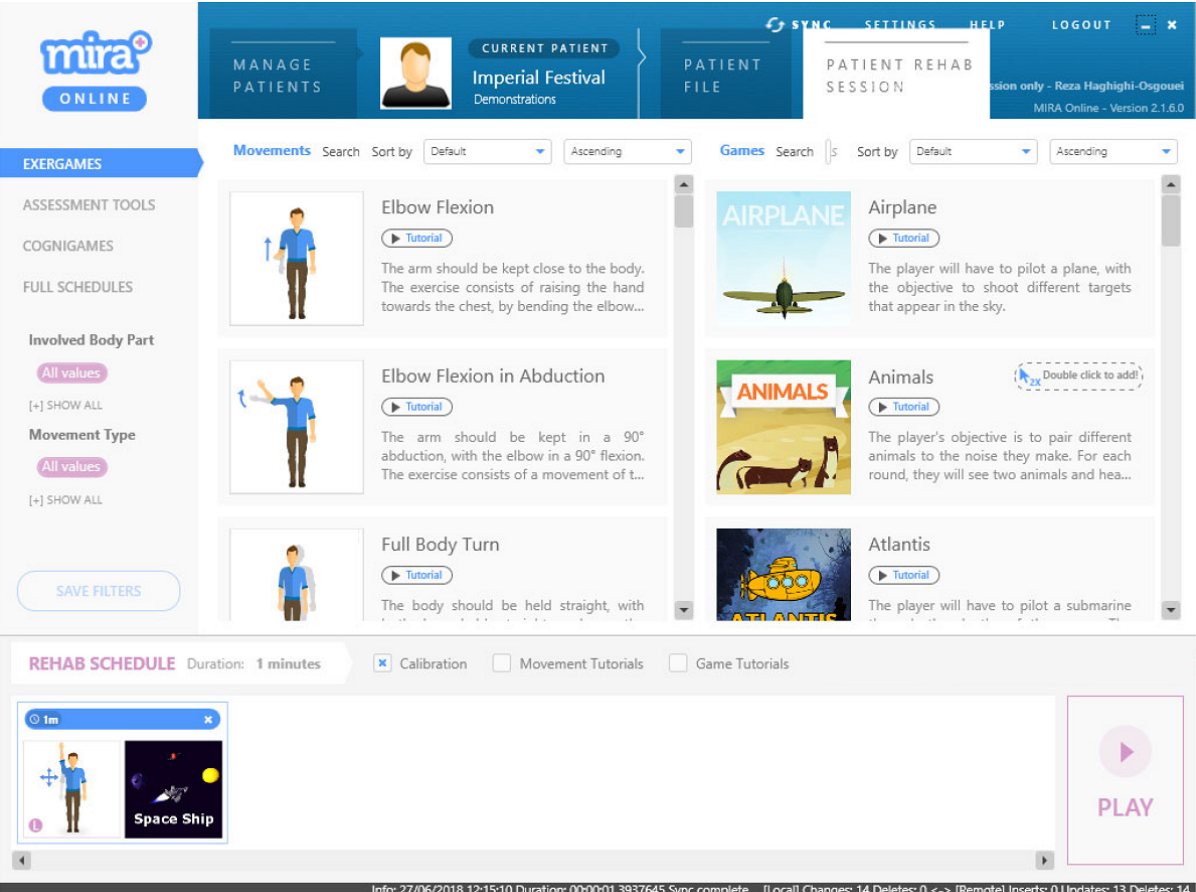
Figure 2. A snapshot of the Medical Interactive Recovery Assistant program. Exercises are listed on the left and games are shown on the right. Multiple game options allow practicing the same exercise with different games, thus encouraging patients to cope with the prescribed exercise by discovering the various game